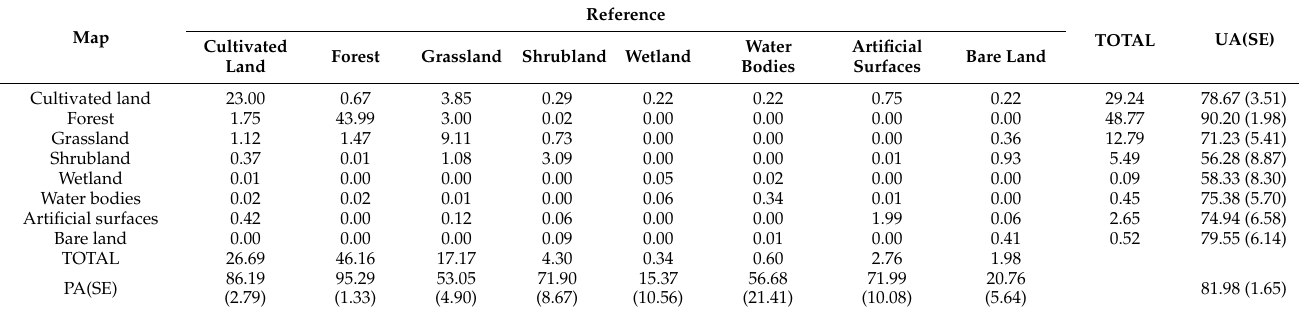
Table A9. Error matrix of fused product 2020 using random forest.